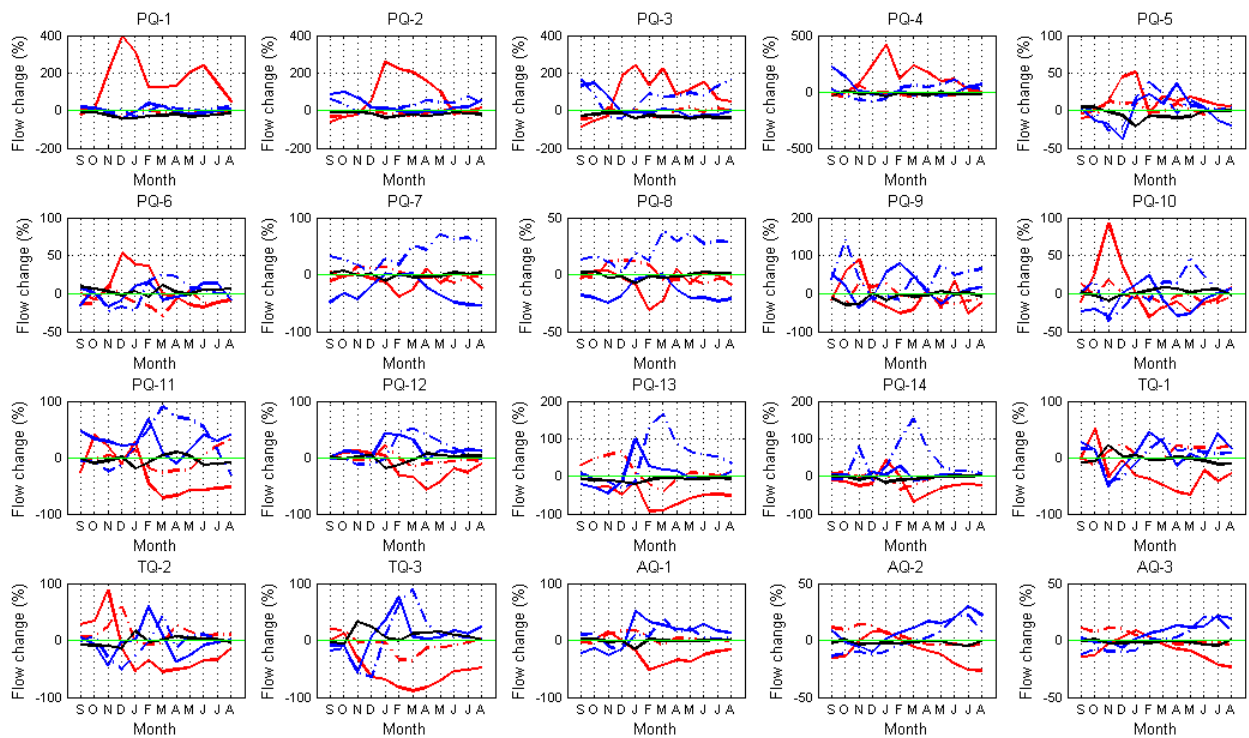
Fig. 3. Deviation of the river flow from the mean value as a function of calendar month for all stations. Red Line: SEN; Dashed-Dotted Red Line: MEN; Black Line: normal; Blue Line: MLN and Dotted Blue Line: SLN, Discharge change (%): change in the discharges related to historical values; x-axis: months and y-axis: change rates (not always the same scale).